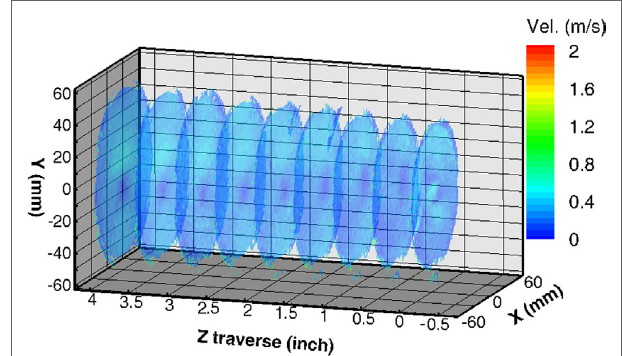
FigUre 6 | Tangential velocity contours at 33 kPa using 50 nm carbon as tracking particles